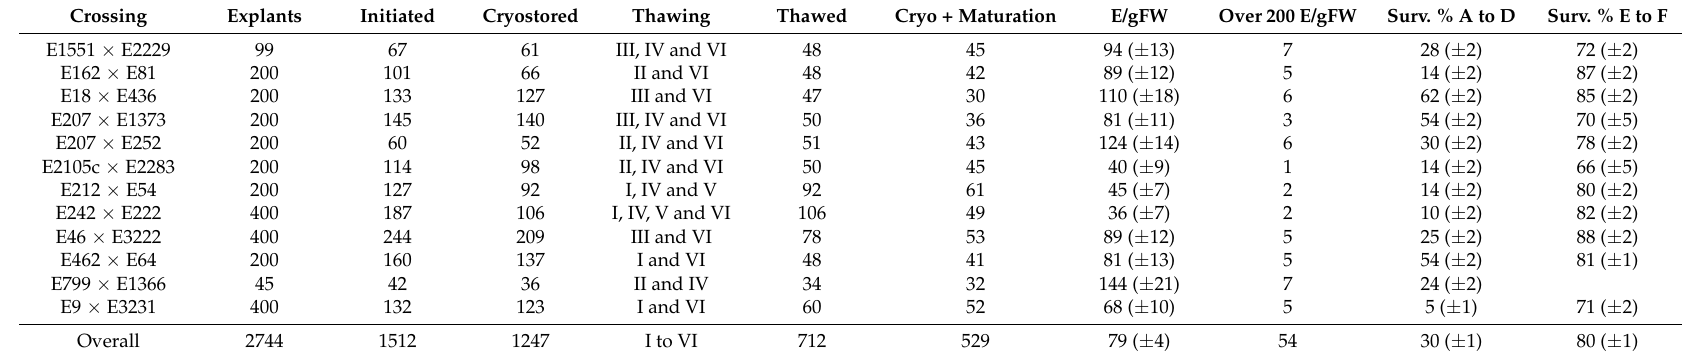
Table 2. Description of material included in Experiment